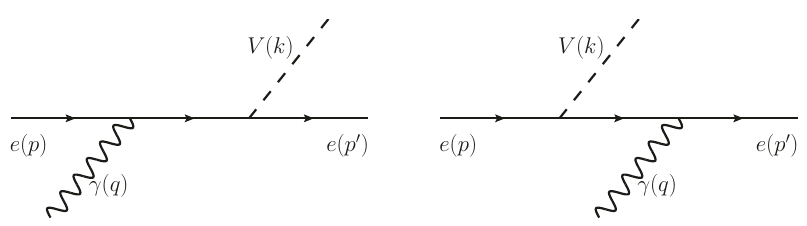
Figure 9 . Feynman diagrams of e − ( p )+ γ ( q ) → e − ( p 0 )+ V ( k ) , where V ( k ) represents the imaginary particle with momentum k , which carries the (multiple) Lorentz indices A . Note that because the matrix element ˜ M (as well as M ) contains the explicit Lorentz indices A , the corresponding i,A i,A “polarization vectors” of V are not included in the calculations of ˜ M i,A